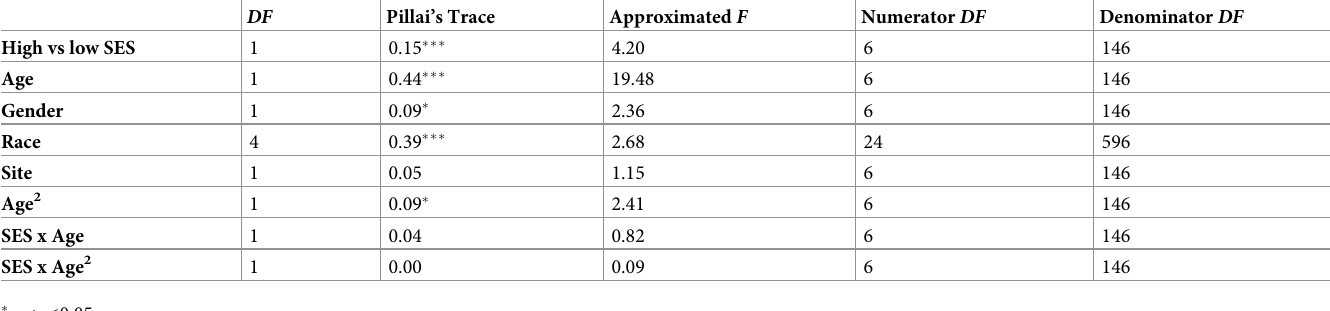
Table 4. MANCOVA as a function of low and high SES controlling for race ( N = 185).